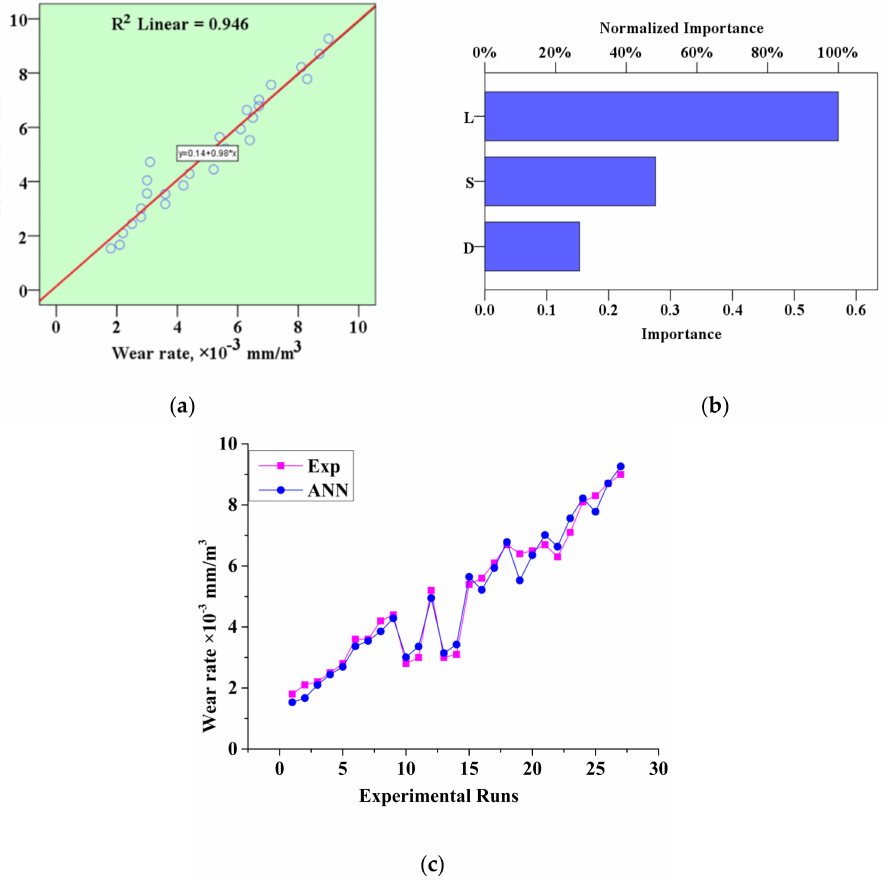
Figure 17. ANN analysis for sample A2: ( a ) experimental vs. predicted values; ( b ) normalized factor importance; and ( c ) error values.